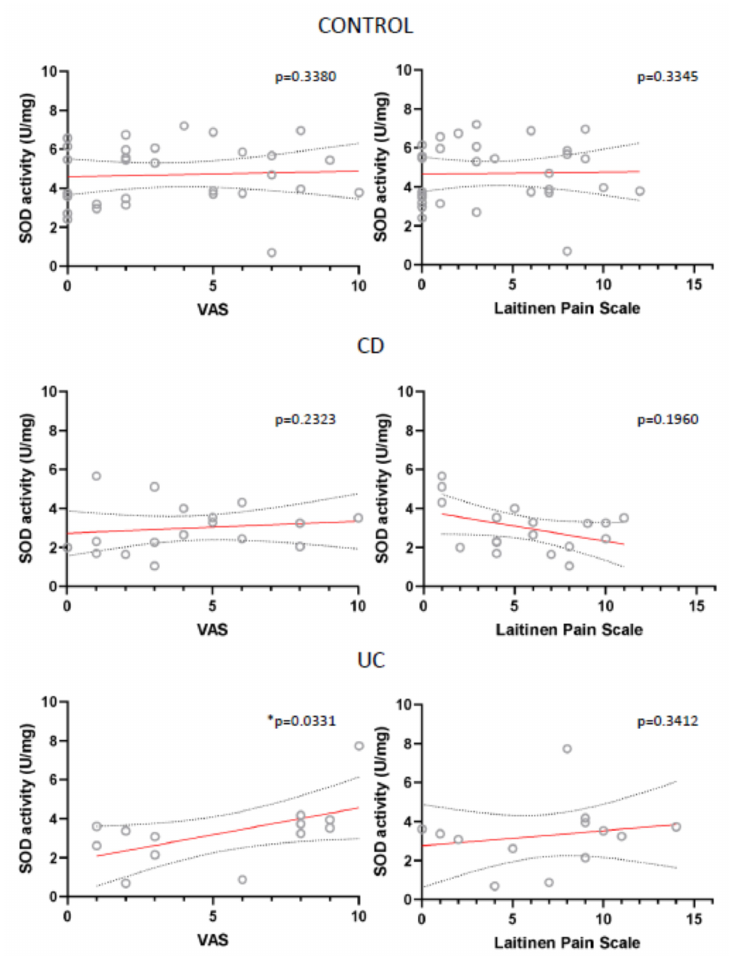
Figure 7. Correlation between the mean values of visual analog scale (VAS) for quantification of disease-related pain, the values of modified Laitinen Pain Scale and SOD activity (U/mg sample) in controls, CD and UC patients.